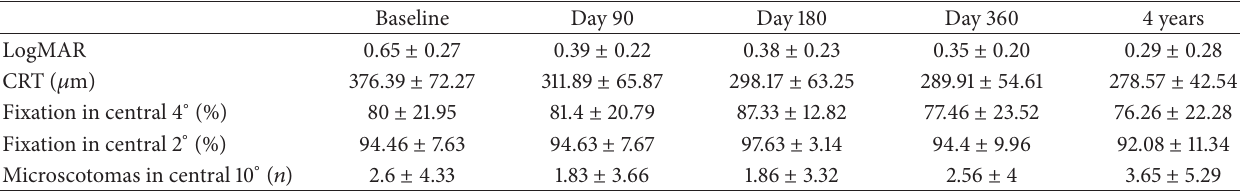
Table 2: Secondary outcomes (mean values ± standard deviation; LogMAR: logarithm of minimal angle of resolution; CRT: central retinal thickness).